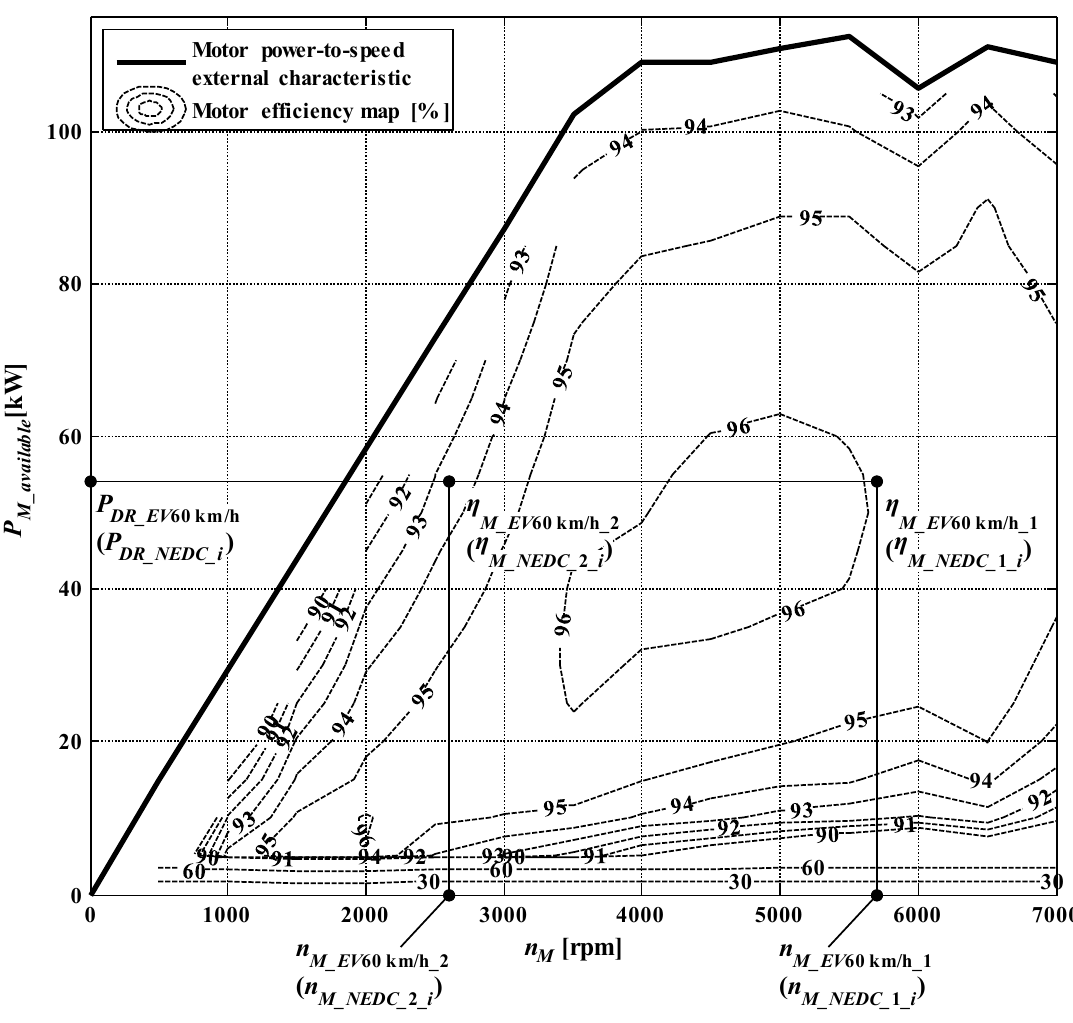
Figure 9. Motor efficiency map.